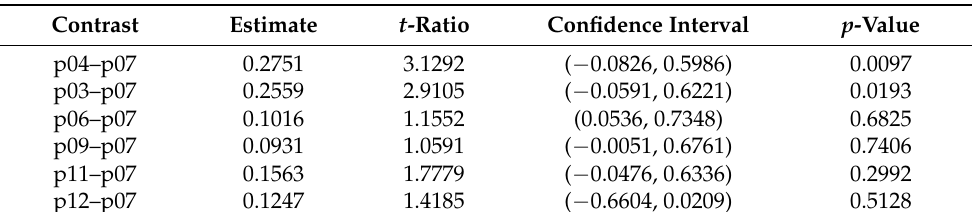
Table 4. Pairwise comparison test (with Dunne tt ’s method adjustment) on energy from di ff erent plots (SE = 0.08792941; df = 59465).